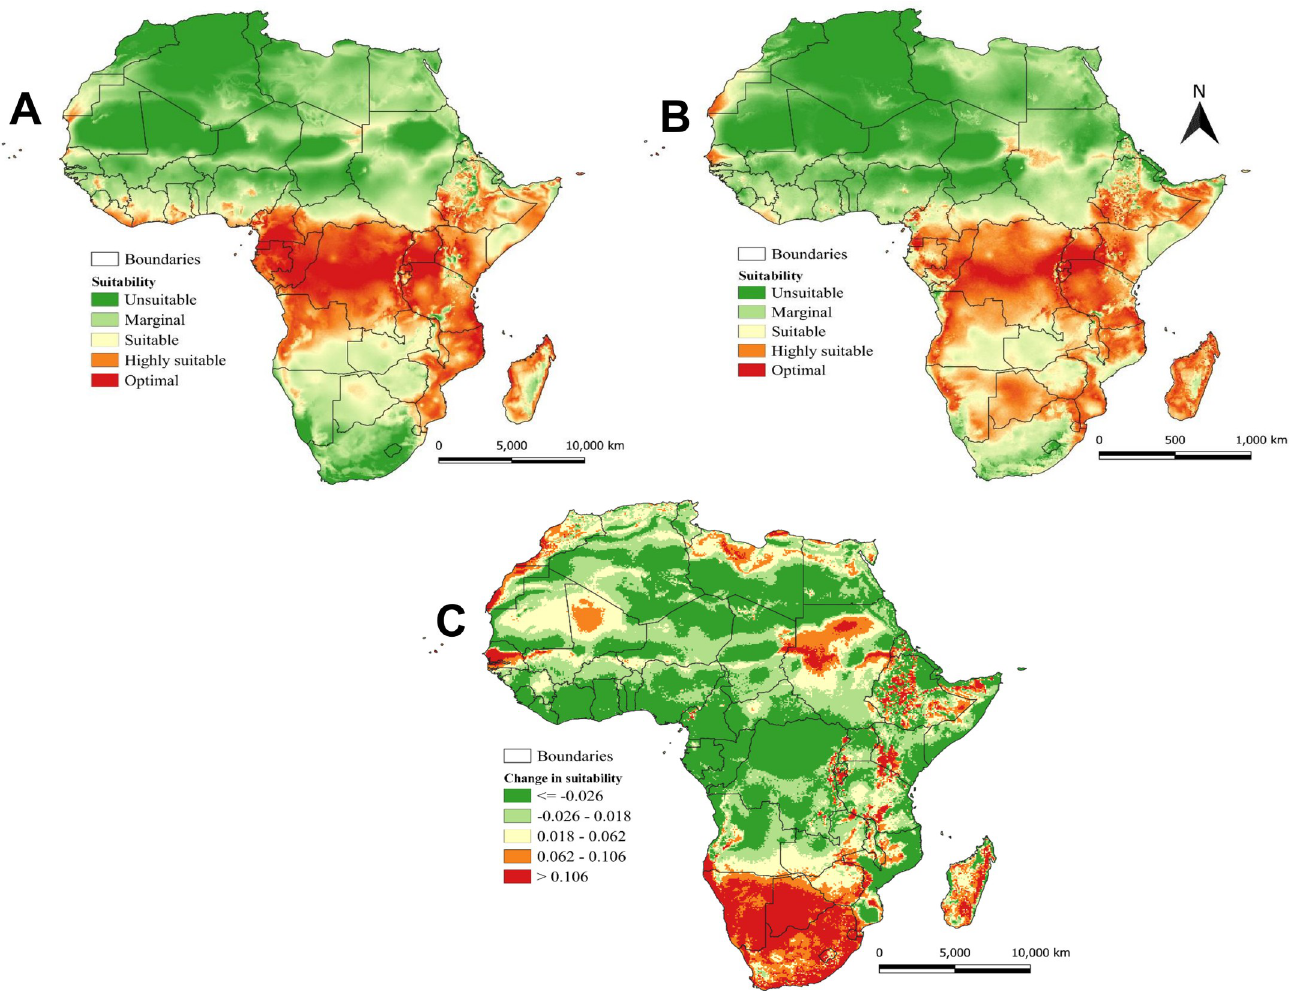
Fig 4. Establishment index (climate suitability) of Diachasmimorpha longicaudata under (A) current (the year 2015), (B) future (the year 2050), and (C) the change in establishment index between current and future climatic conditions predicted using the ILCYM model. The Establishment index is identifying the areas in which D . longicaudata may survive and become established. Indices < 0.2 indicate unsuitable areas, 0.2–0.4 for marginally suitable areas, 0.4–0.6 for suitable areas, 0.6–0.8 for the highly suitable areas, and > 0.8 for the optimal areas. Republished from Fick et al . 2017 [41] under a CC BY license, with permission